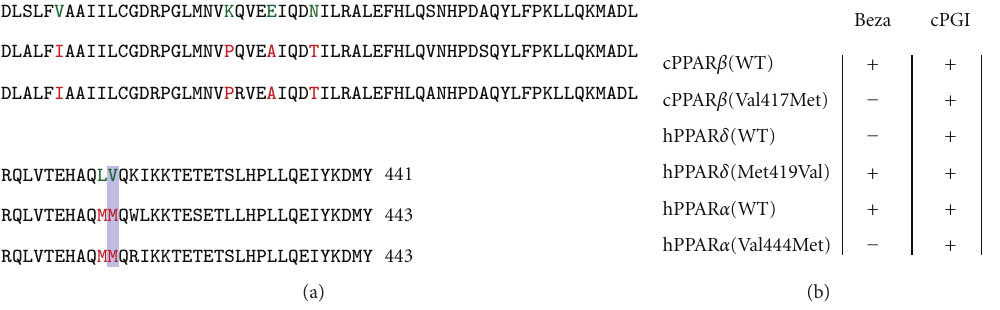
RQLVTEHAQMMQRIKKTETETSLHPLLQEIYKDMYKEIGVHVFYRCQCTTVETVRELTEFAKSIPSFIGLYLNDQVTLLKYGV NEISVHVFYRCQSTTVETVRELTEFAKNIPNFSSLFLNDQVTLLKYGV KEISVHVFYRCQCTTVETVRELTEFAKSIPSFSSLFLNDQVTLLKYGV HEAIFAMLASIMNKDGLLVANGNGFVTREFLRTLRKPFNEIMEPKFEFAVKFNALELDDS HEAIFAMLASIVNKDGLLVANGSGFVTHEFLRSLRKPFSDIIEPKFEFAVKFNALELDDS HEAIFAMLASIVNKDGLLVANGSGFVTREFLRSLRKPFSDIIEPKFEFAVKFNALELDDS DLSLFVAAIILCGDRPGLMNVKQVEEIQDNILRALEFHLQSNHPDAQYLFPKLLQKMADL DLALFIAAIILCGDRPGLMNVPQVEAIQDTILRALEFHLQVNHPDSQYLFPKLLQKMADL DLALFIAAIILCGDRPGLMNVPRVEAIQDTILRALEFHLQANHPDAQYLFPKLLQKMADL RQLVTEHAQLVQKIKKTETETSLHPLLQEIYKDMY RQLVTEHAQMMQWLKKTESETLLHPLLQEIYKDMY F 4: (a) Alignment of amino acid residues of chicken, mouse, and human PPAR LBDs. LBD is located at the C-terminus of chicken (amino acid residues 243 to 441) and mammalian (245 to 443) PPAR / proteins. Amino acid residues conserved between mouse and human but not in chicken are highlighted in orange (mammals) and green (chicken). e amino acid residues critical for beza�brate-dependent 𝛽𝛽 𝛿𝛿 response of PPAR are indicated by a purple box. Accession numbers are as follows: cPPAR 𝛽𝛽 𝛿𝛿 (Met417Val) as previously reported 𝛽𝛽